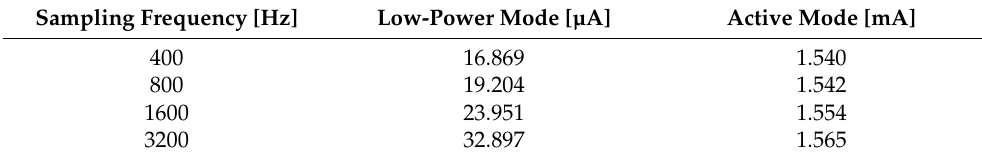
Figure 15. Measurements on journey from Osijek to Dubrovnik (1600 Hz with FIFO). Acceleration magni- tude waveform measured inside the package on figures ( a ) (first measurement), ( b ) (second measurement). Table 2. Measured Smart Sticker current consumption with various acceleration sampling frequencies.